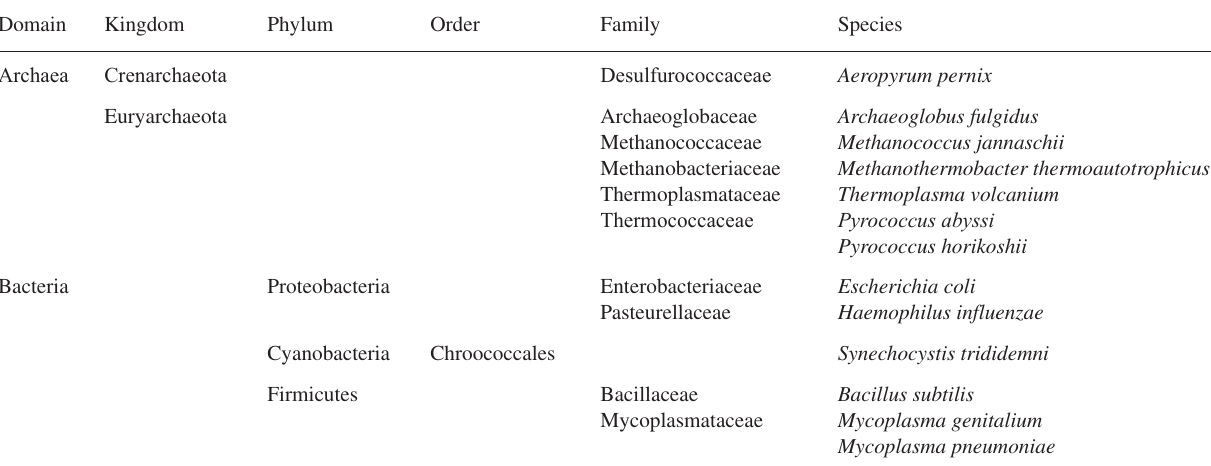
Table1. Archaealand bacterialspeciesanalyzed.The sixbacterialspecieslistedbelow served asnegative (non-archaeal)controlsforthestudy.